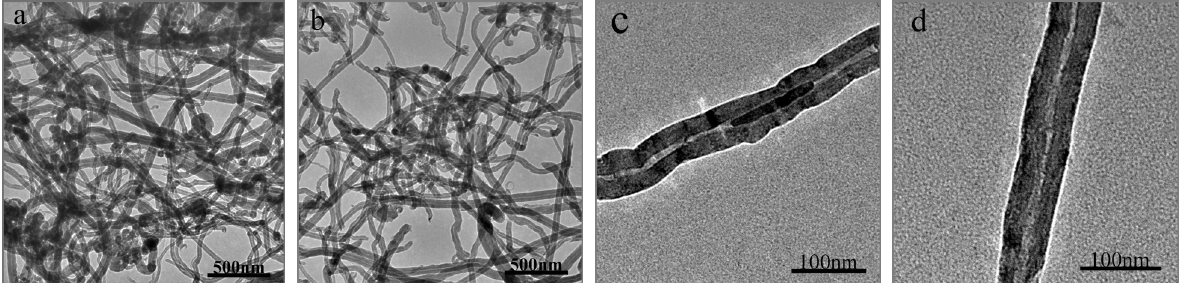
Fig. 1 TEM micrographs of (a) pristine MWCNTs, (b) plasma treated MWCNTs (P-MWCNTs), (c) high magnification of pristine MWCNTs, and (d) high magnification of P-MWCNTs.